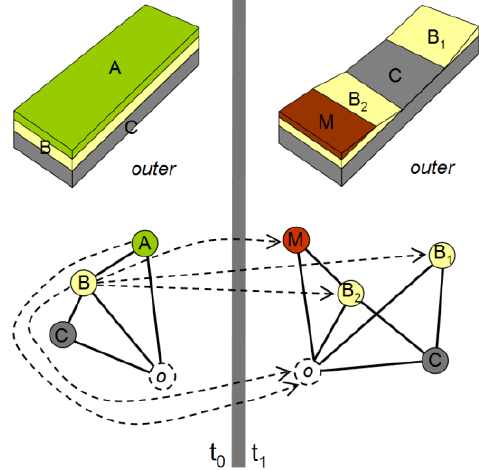
Figure 8. Representation of a landform by LandFormState at t 0 and t 1 and the change between these two points in time by Abstract_GeoProcesses (dashed